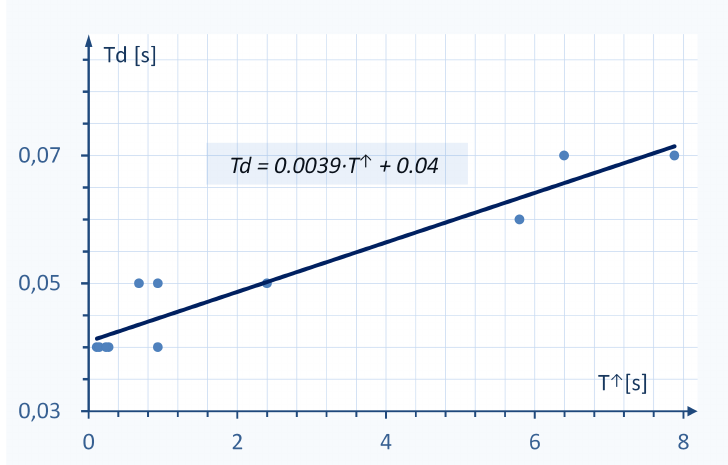
Figure 14. The derivative time, T d , versus the time constant, T ↑